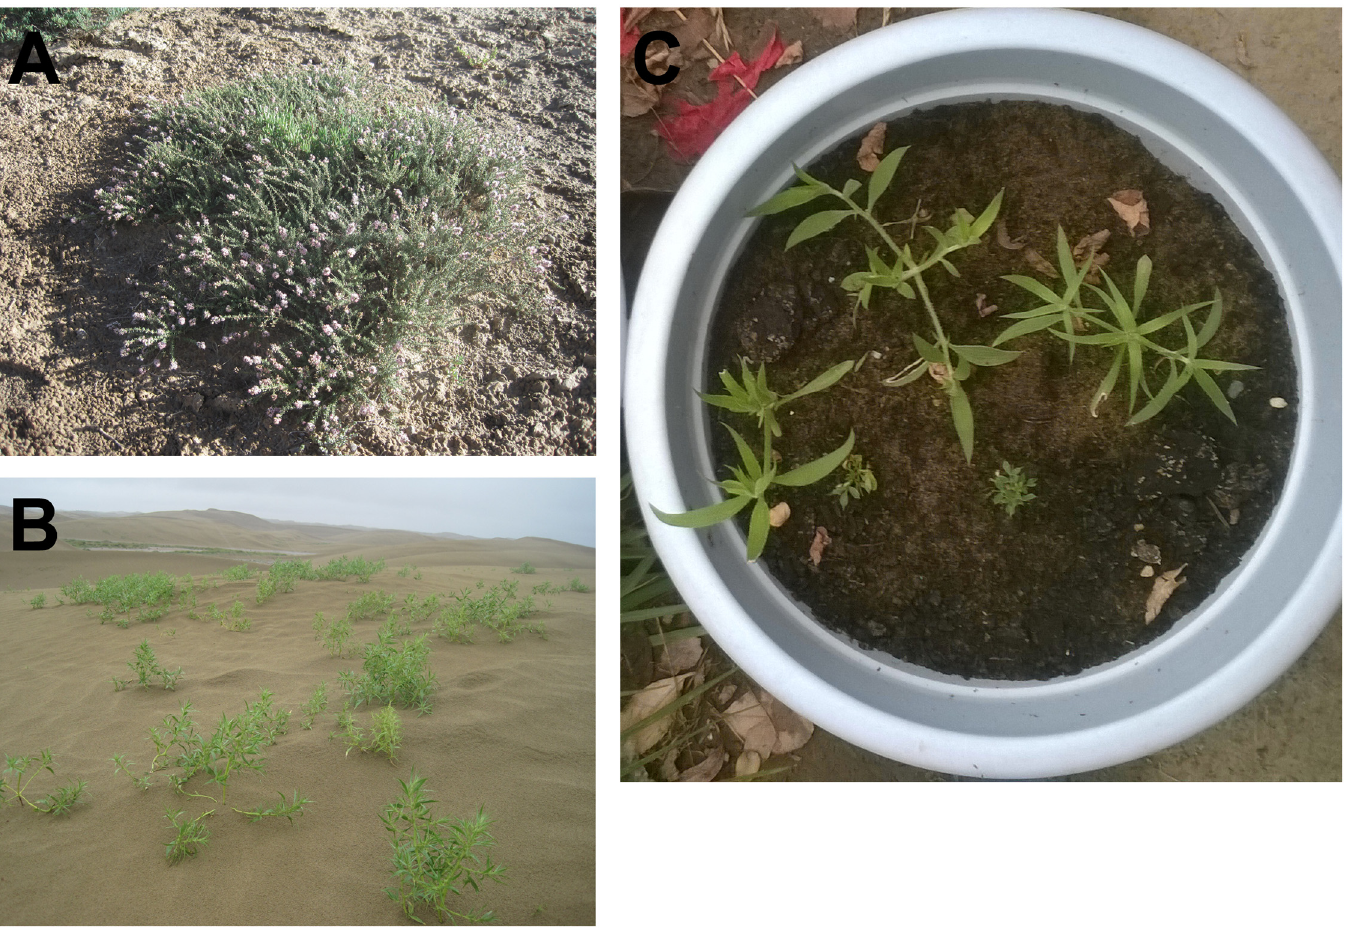
Fig 1. Habitat and shoot architecture. Habitat (A and B) of R . soongorica and sand rice in China; (C) the branch priority of sand